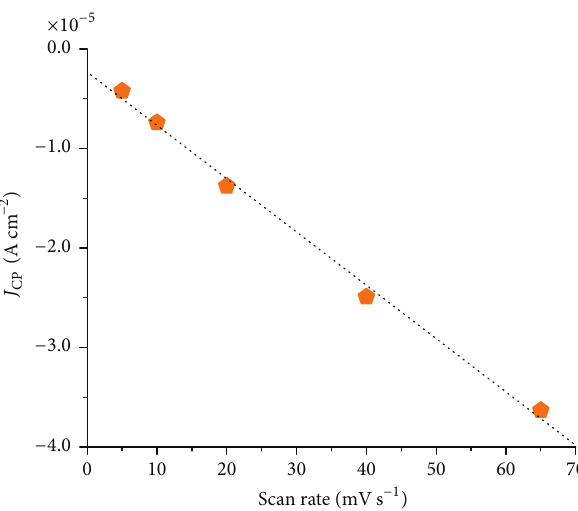
Figure 11: Scan rate dependence of the cathodic peak positioned at around 3.1 V versus Li + /Li for the sample of CS NiO ( 𝑙 = 0.3 𝜇 m) spray-deposited onto ITO. Cell configuration and electrolyte com- position as in Figure 1. Data extracted from Figure 7.